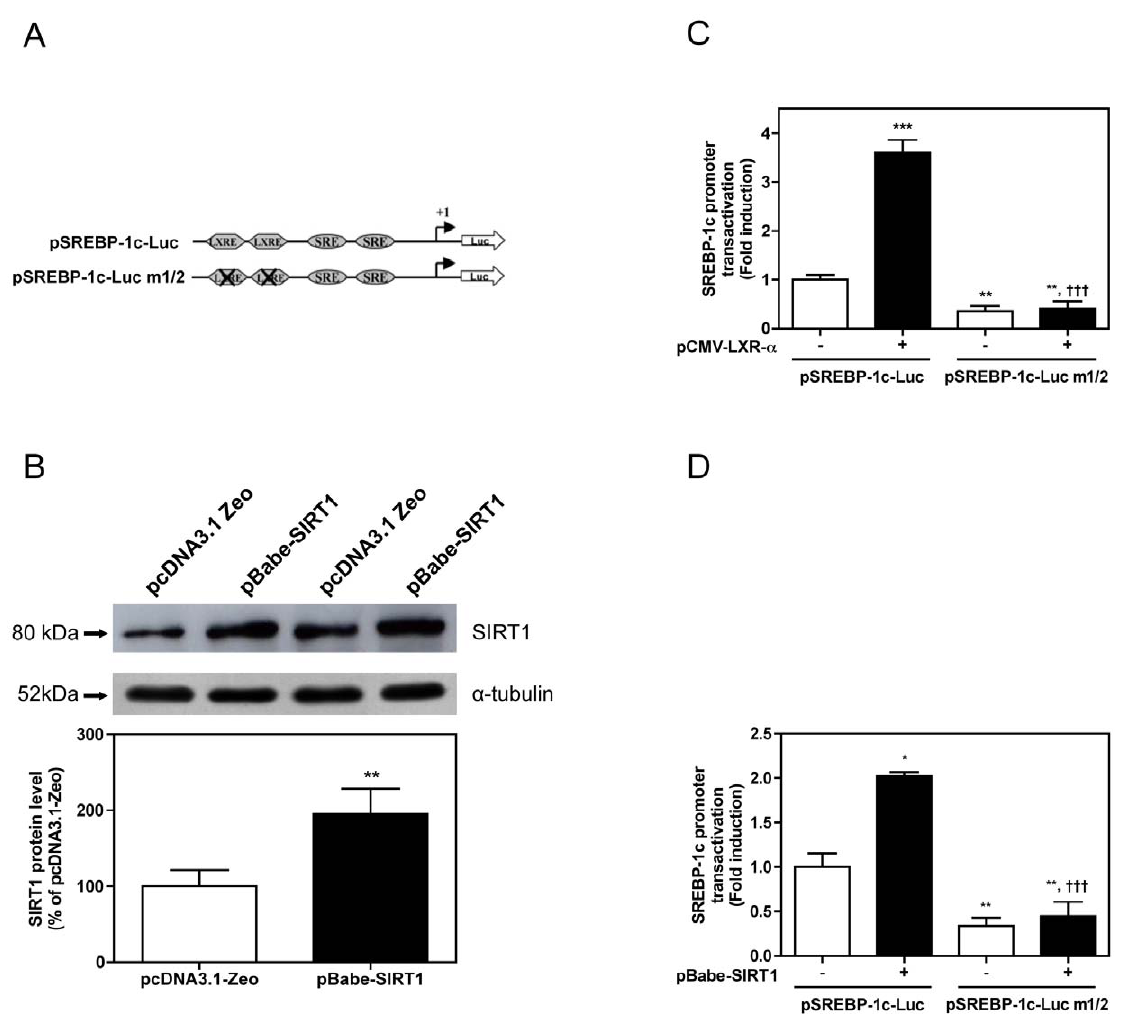
Figure 4. Sirtuin 1 (SIRT1) regulates sterol regulatory element binding protein (SREBP)-1c promoter transactivation. (A) Human SREBP-1c promoter ( 2 571/ + 90 bp) reporter construct (pSREBP-1c-Luc) and human SREBP-1c promoter reporter construct with two deleted mutations in LXR-response elements located at 2 311/ 2 296 bp and 2 260/ 2 245 bp (pSREBP-1c-Luc m1/2) [18]. (B) SIRT1 protein level in mouse tibialis anterior muscle 7 days after electrotransfer of a control vector (pcDNA3.1-Zeo) or a SIRT1 expression vector (pBabe-SIRT1). Equal protein loading was controlled by measuring total protein content and a -tubulin expression by western blot. Data are means 6 SE (n=8/group). ** P , 0.01: significantly different from pcDNA3.1-Zeo. (C) pSREBP-1c-Luc and pSREBP-1c-Luc m1/2 transactivation in absence and presence of a LXR- a expression vector (pCMV-LXR- a ). Tibialis anterior muscles were removed 7 days after gene electrotransfer. Luciferase activity was normalized to b -galactosidase activity to correct for variations in transfection efficiency. Data are means 6 SE (n=8/group). ** P , 0.01 and *** P , 0.001: significantly different from pSREBP-1c-Luc alone. {{{ P , 0.001: significantly different from pSREBP-1c-Luc with pCMV-LXR- a . (D) pSREBP-1c-Luc and pSREBP-1c-Luc m1/2 transactivation in absence and presence of pBabe-SIRT1. Tibialis anterior muscles were removed 7 days after gene electrotransfer. Luciferase activity was normalized to b -galactosidase activity to correct for variations in transfection efficiency. Data are means 6 SE (n=8/group). * P , 0.05 and ** P , 0.01: significantly different from pSREBP-1c-Luc alone. {{{ P , 0.001: significantly different from pSREBP-1c-Luc with pBabeSIRT1. nitrocellulose membranes. The blots were incubated overnight at [41], corrected for amplification efficiency variability between genes [42], and improved for use of multiple reference genes [43]. Immunoblot analysis. Muscle samples were homogenized (1:20 dilution, wt/vol) at 4 u C [50 mM Tris-HCl (pH= 7.4), 100 mM NaCl, 2 mM EDTA, 2 mM EGTA, 50 mM ß-glycero- phosphate, 50 mM sodium fluoride, 1 mM Na 3 VO 4 , 120 nM okadaic acid, 1% Triton X-100]. Homogenates were centrifuged at 12,000 g for 20 min at 4 u C. Human myotube lysates were chemiluminescent protein detection (ECL, GE Health Care). prepared as previously described [18]. Protein concentration was Equal protein loading was controlled by measuring a -tubulin spectrophotometrically measured at 750 nm using the Bio-Rad content by western blot. Membranes were stripped (Re-Blot Plus DC protein assay. Depending on the antibody used, either 20 or Strong Solution, Millipore), checked for the absence of immuno- 50 m g of proteins were subjected to SDS-PAGE and transferred to reactivity, incubated with a -tubulin (1:500, Sigma T5168), and